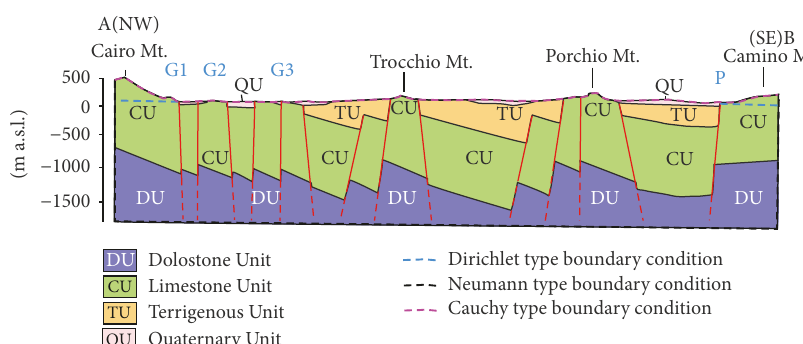
Figure 4: Hydrogeological section for numerical purposes from Centamore et al. [37] modified on the basis of additional data [23–25, 44] and imposed boundary condition. Red lines indicate the faults. An inner gradient of 0.5% has been set from Cairo Mt. to Gari Spring (G1, G2, and G3) and from Camino Mt. to Peccia Springs (P), no flow condition (Neumann condition at the bottom and at the lateral edges), and a head dependent boundary (Cauchy condition) along the topographic surface. Dolostone and limestone units (DU and CU) represent the aquifer and terrigenous unit (TU) and Quaternary unit (QU) the aquiclude and the aquitard of the system.